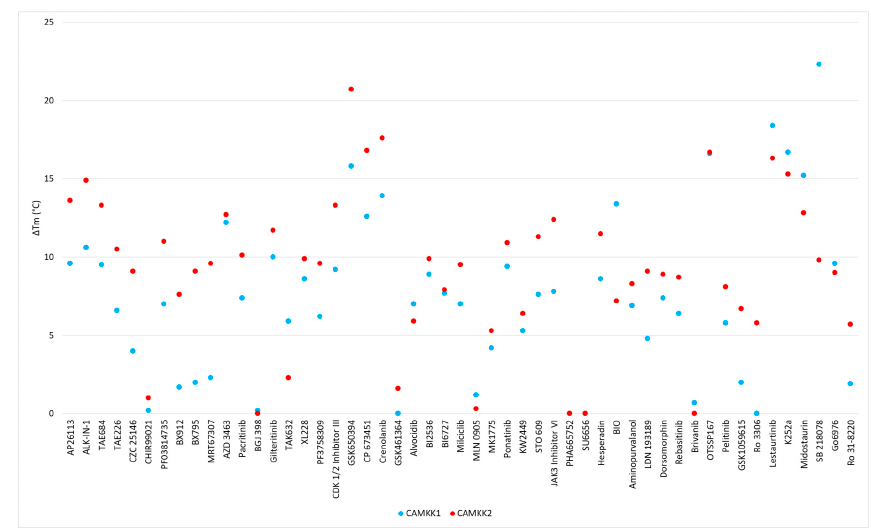
Figure 5. DSF results for literature inhibitors tested on CAMKK1 and CAMKK2. Results are the mean of three repeats run simultaneously under identical conditions. Compounds that yielded negative values are presented as having Δ T m = 0 °C. Table 1. The inhibitors acquired and tested and their scaffold types. DSF results are a mean of n = 3 runs. IC 50 values were generated in an 8-point full dose response assay. (* Assay interference; # n = 1).